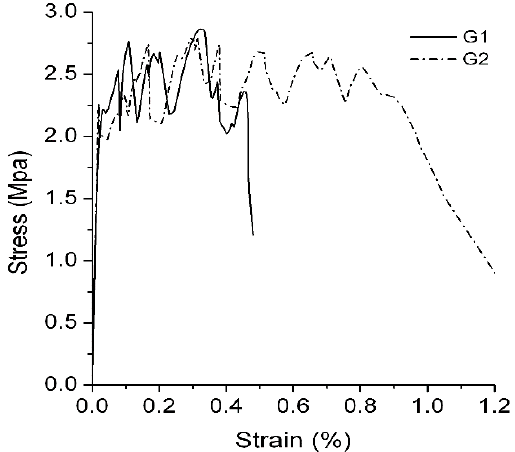
Figure 7. Stress-strain curve of G1 and G2.